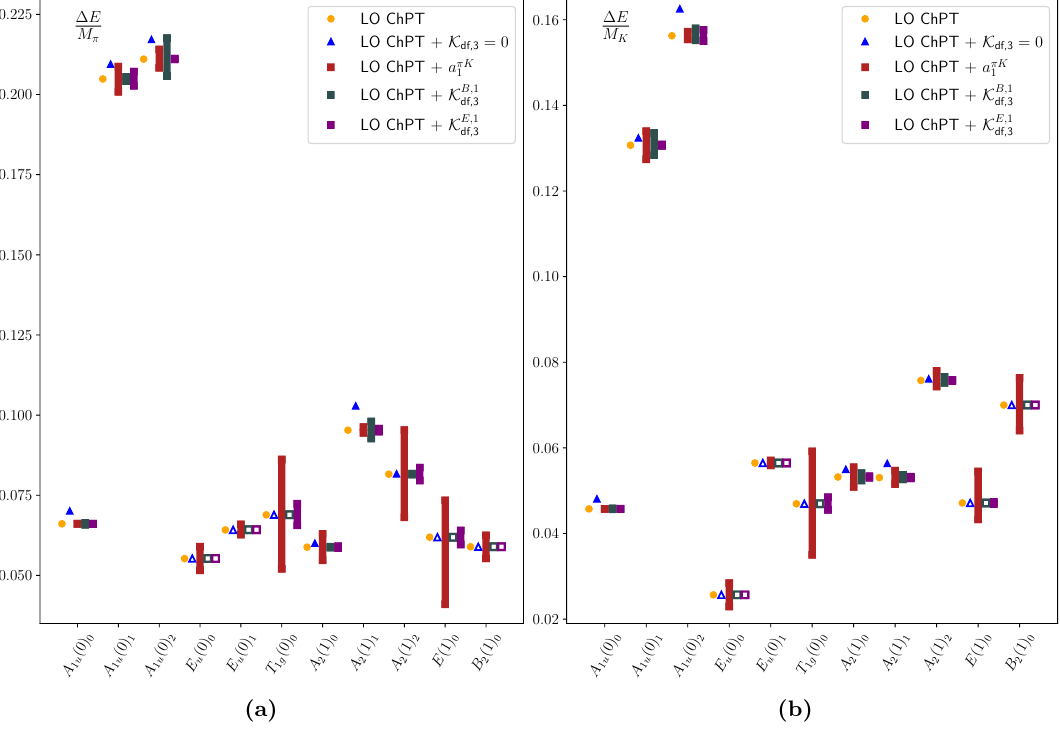
Figure 4. Shifts in the CMF energy of various levels with different choices of parameters in K 2 and K for (a) the π + π + K + and (b) the π + K + K + systems. The levels are denoted along the df , 3 bottom of the figures using the notation irrep( d 2 while the subscript 0 , 1 , . . . denotes the level, with 0 being the ground state in the given irrep and frame. For each level, there are five points, as discussed in the